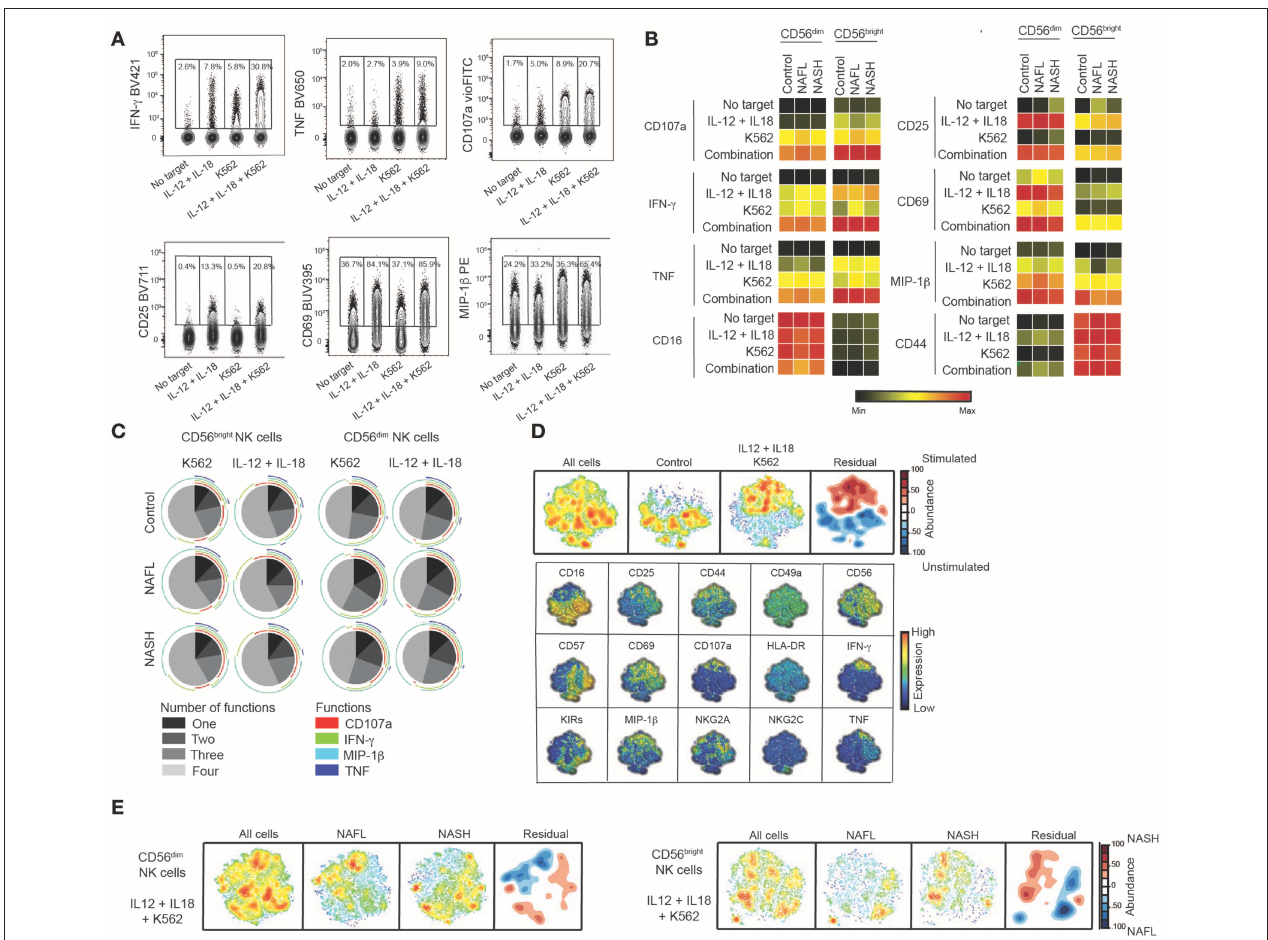
FIGURE 3 | Retained functional capacity of circulating NK cells in NAFLD. (A) Representative concatenated flow cytometry plots showing CD56 dim NK cell responses following the indicated stimulations. (B) Heat map summarizing the mean frequency of responding NK cells for the measured functions and indicated stimulations in healthy controls ( n = 15), NAFL patients ( n = 10), and NASH patients ( n = 16). (C) Multifunctional analysis of the combination of degranulation (CD107a) and cytokine production (IFN- γ , MIP-1 β , and TNF) responses for IL-12 + IL-18 stimulation and/or co-culture with K562 target cells. (D) SNE plots of total cells from healthy donors subsequently divided in stimulated and un-stimulated cells. The residual plot highlights the decreased (blue) or more highly expressed (red) areas in the stimulated cells. Underneath, individual plots of the expression of 15 single markers are shown. (E) SNE plots depicting the difference between CD56 dim (left) and CD56 bright (right) NK cells from NAFL and NASH patients after IL-12 + IL-18 + K562 stimulation where the density plots highlight the specific changes in NASH